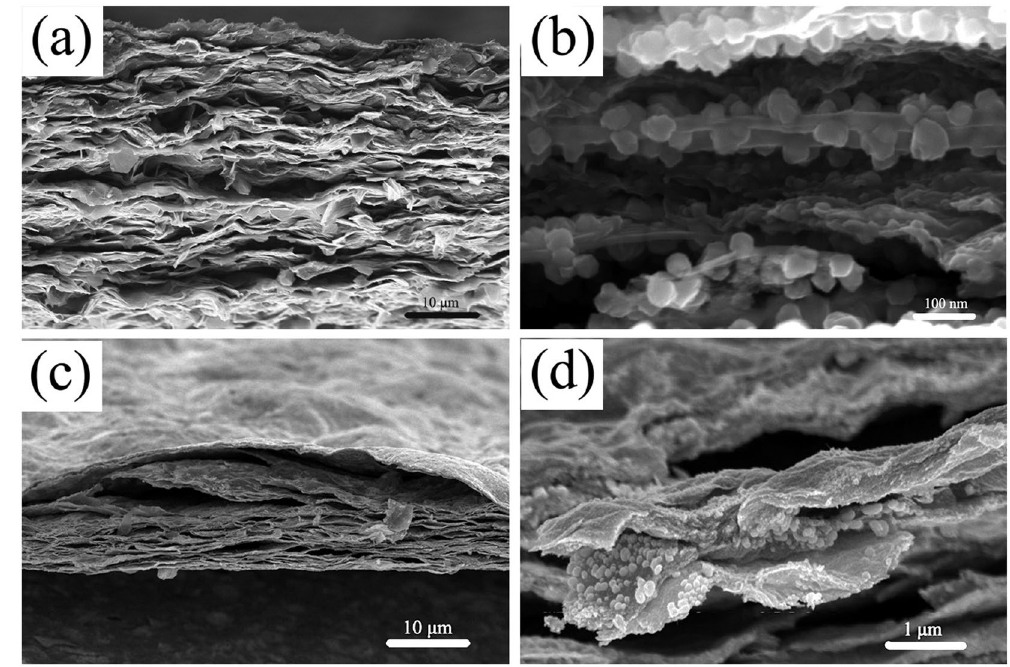
Figure 4. Cross-sectional SEM images: ( a , b ) Co/GS film; ( c , d ) Co 3 O 4 /GS